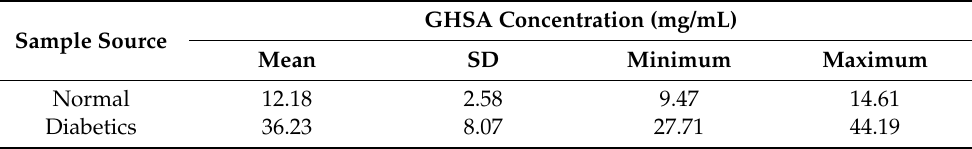
Table 3. Summary of GHSA concentrations analyzed by the developed electrochemical aptasensor. Sample